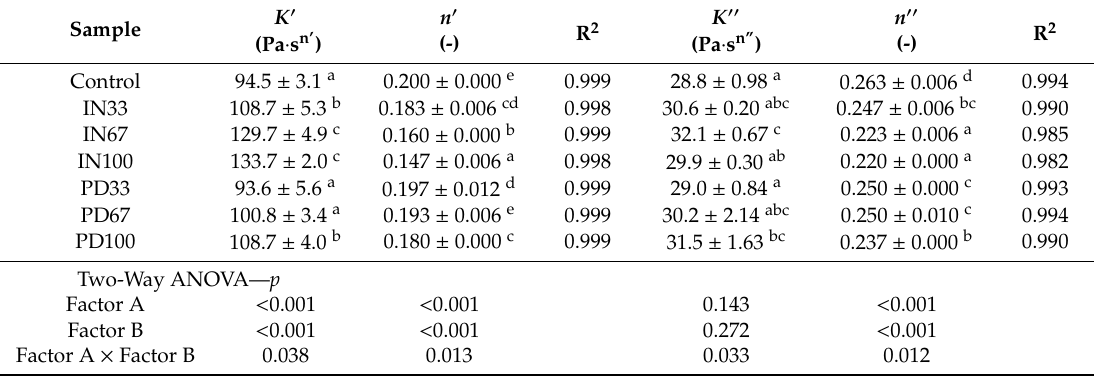
Table5. Parameters ofpower law equationsdescribing mechanicalspectra of potatostarch